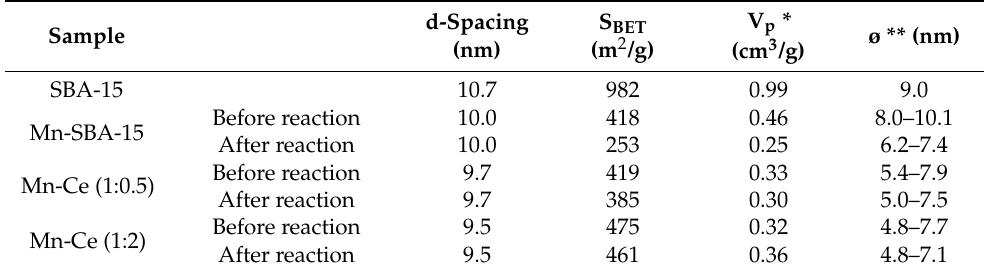
Table 1. d-spacing values, specific surface area (S BET ), total pore volume (V p ) and pore diameter (ø) of the catalysts before (BR) and after (AR) reaction (propane